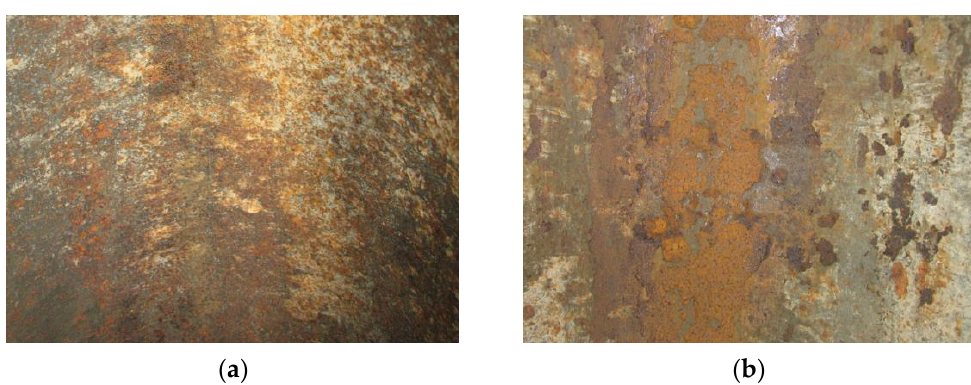
Figure 14. Corrosion defects at the inner surface of the pipeline made of the X52 steel: ( a ) top, ( b ) bottom. Scale 1:2.